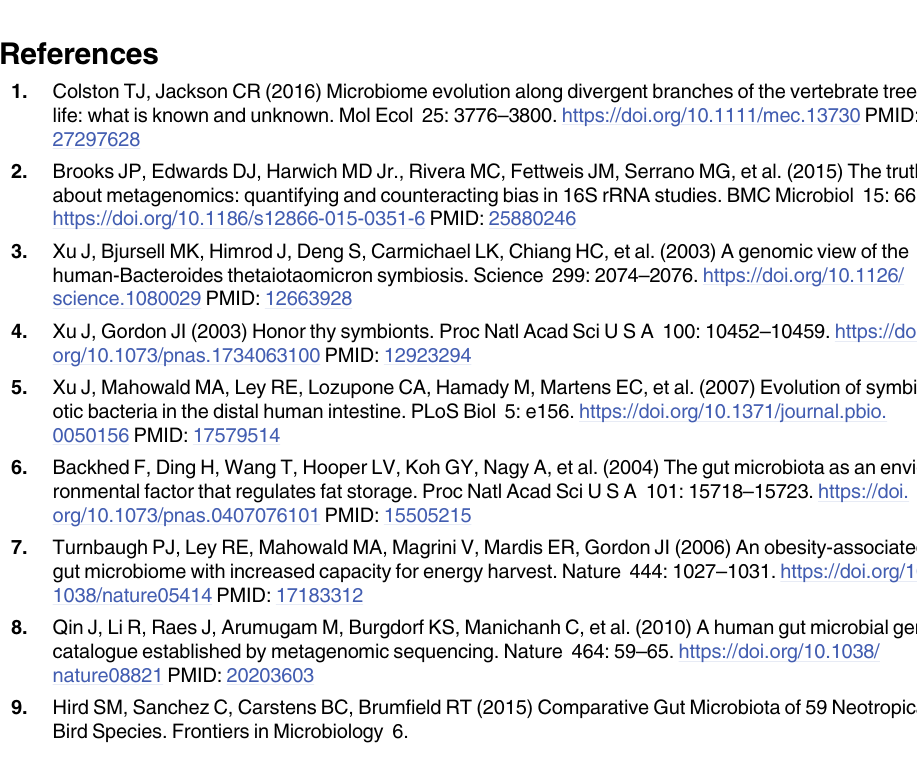
S2 Fig. Matrix of the bacteria present in the nine samples. Blue boxes indicate the presence. (TIF) S1 Table. Total number of OTUs resulting from the QIIME